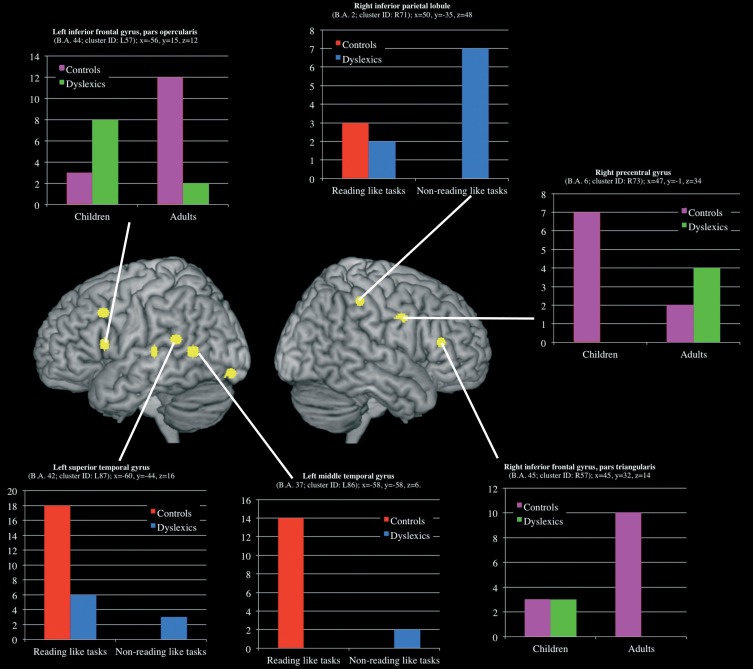
Clusters that showed a significant group-by-task and group-by-age interaction effect. For each clusters a histogram describe the peak distribution across group/conditions.